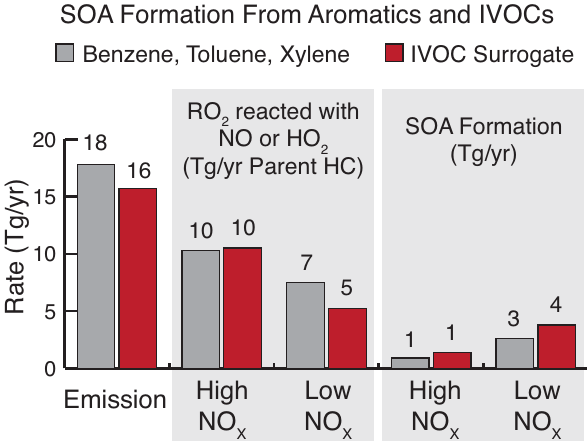
Fig. 5. Emission, oxidation, and aerosol formation from aromatics and IVOCs. Simulation performed at 2 ◦ × 2 . 5 ◦ with GEOS-4 mete-